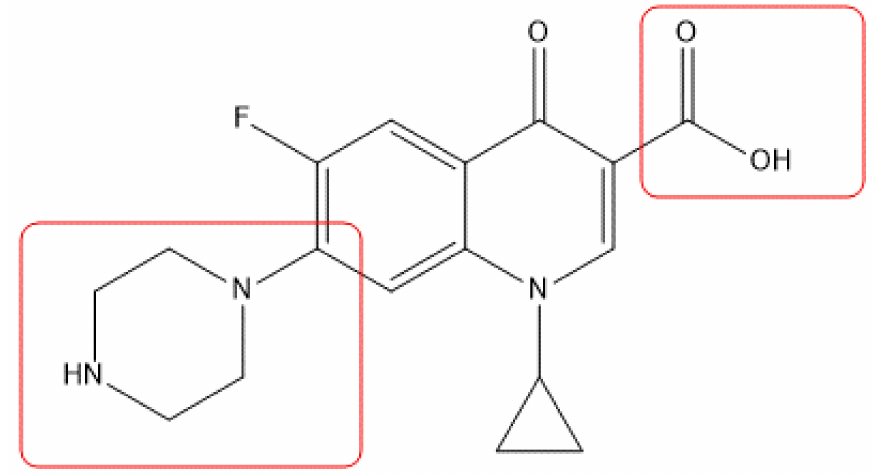
Figure 1. Ciprofloxacin structure with marked fragments that were modified.